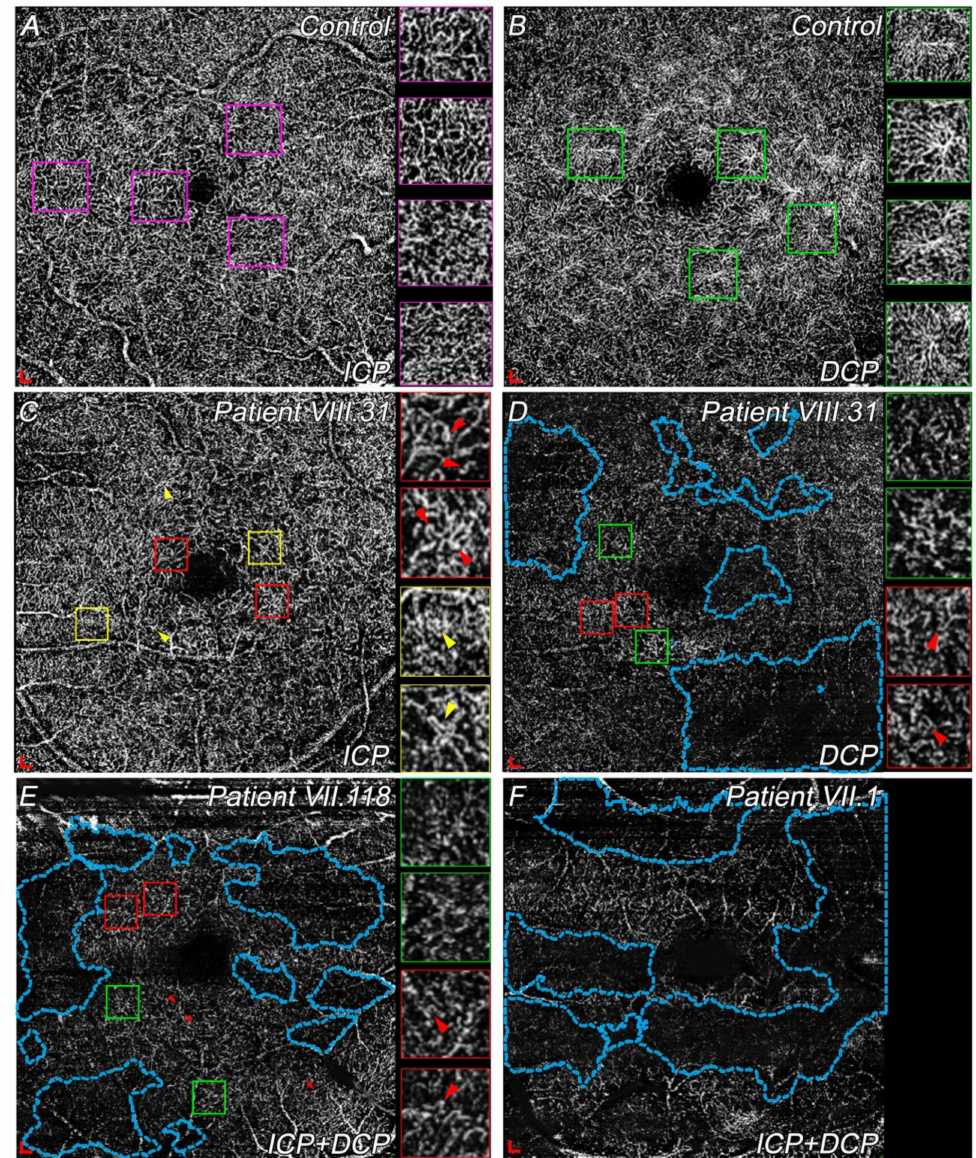
Figure 4. OCTA images of ICP and DCP centered at the macula in controls and patients with choroidal dystrophies. Insets at the right side of B, C, D, and E show different vascular signs in high magnification. ( A ) ICP of a healthy patient. Insets display the typical vessels with tortuosity. ( B ) DCP of a control subject where spider-like (green squares) structures surrounding the fovea can be seen. ( C ) ICP of patient VII.31 (LE) showing IRMAs (yellow arrowheads) and some capillary bends (red arrowheads). ( D ) Capillary dropout or slow blood flow areas (blue areas) with some degenerate spider-like structures (green squares) and capillary bends (red arrowheads), observed in the DCP of patient VII.31 (LE). ( E ) ICP and DCP images of VII.118 (RE), where larger areas of impaired vascular perfusion (blue areas) were detected in addition to some altered spider-like structures (green square) and capillary bends (red arrowheads). ( F ) Single slab of ICP and DCP of VII.1 (LE) showing widespread capillary dropout areas (blue areas). No spider-like structures were detected. Scale: 200 × 200 µ m. Abbreviations: intermediate capillary plexus, ICP; deep capillary plexus, DCP; left eye, LE; right eye, RE. Green squares show spider-like structures; red squares indicate capillary bends or vascular loops; blue squares show